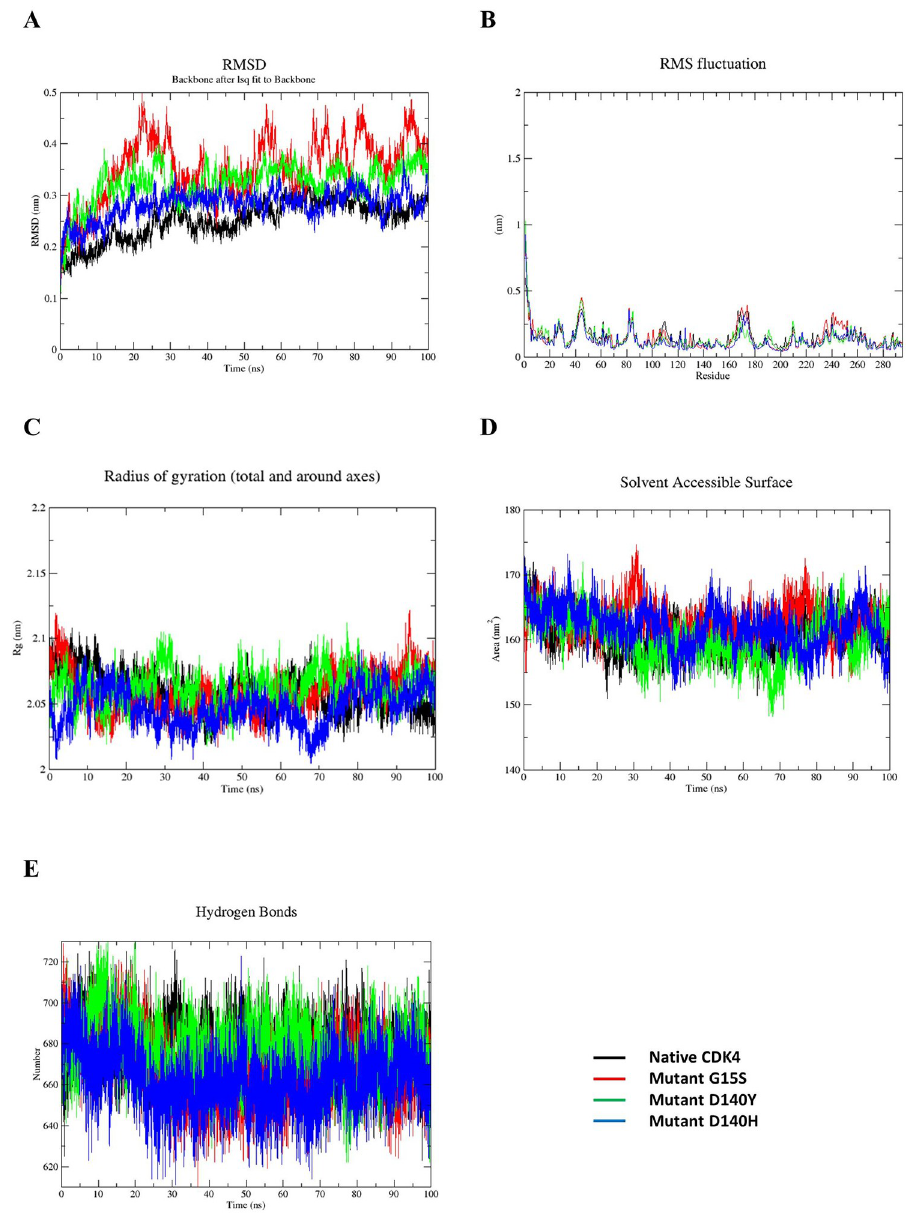
Fig 8. Molecular dynamics analysis (RMSD, RMSF, Rg, SASA and H-bond) of native and mutant CDK4 protein at 100 ns. (A) RMSD values of C α atoms of native and mutant structures. X-axis is RMSD (nm), and the y-axis is time (ns) (B) RMSF values of the carbon alpha over the entire simulation. X-axis is RMSF (nm), and the y-axis is residue. (C) Rg of the protein backbone over the entire simulation. X-axis is Rg (nm), and the y-axis is time (ps). (D) Solvent accessibility of native and mutant proteins. X-axis is SASA (nm 2 ), and the y-axis is time (ns). (E) Total number of H- bond count throughout the simulation of native and mutant structures. The symbol coding scheme is as follows: native (black colour), mutant G15S (red colour), mutant D140Y (blue) and D140H (green colour).